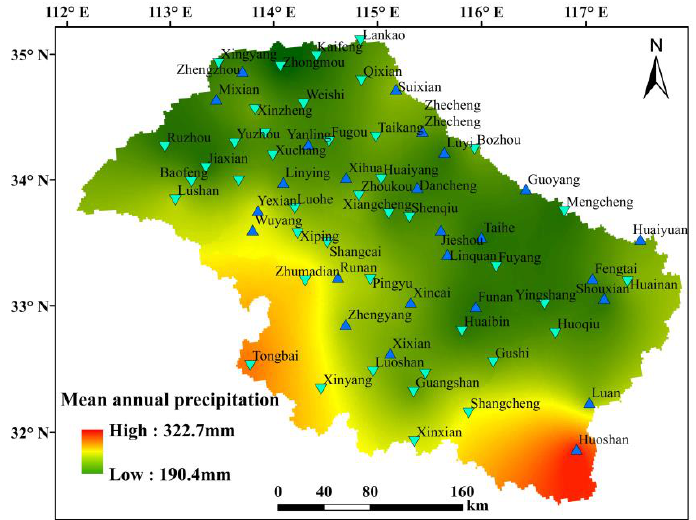
Figure 3. Spatial distribution of annual average precipitation and trend determined using the Mann-Kendall (MK) test during the critical water period for summer maize growth. Note: , denotes precipitation is on the rise or decline, respectively.